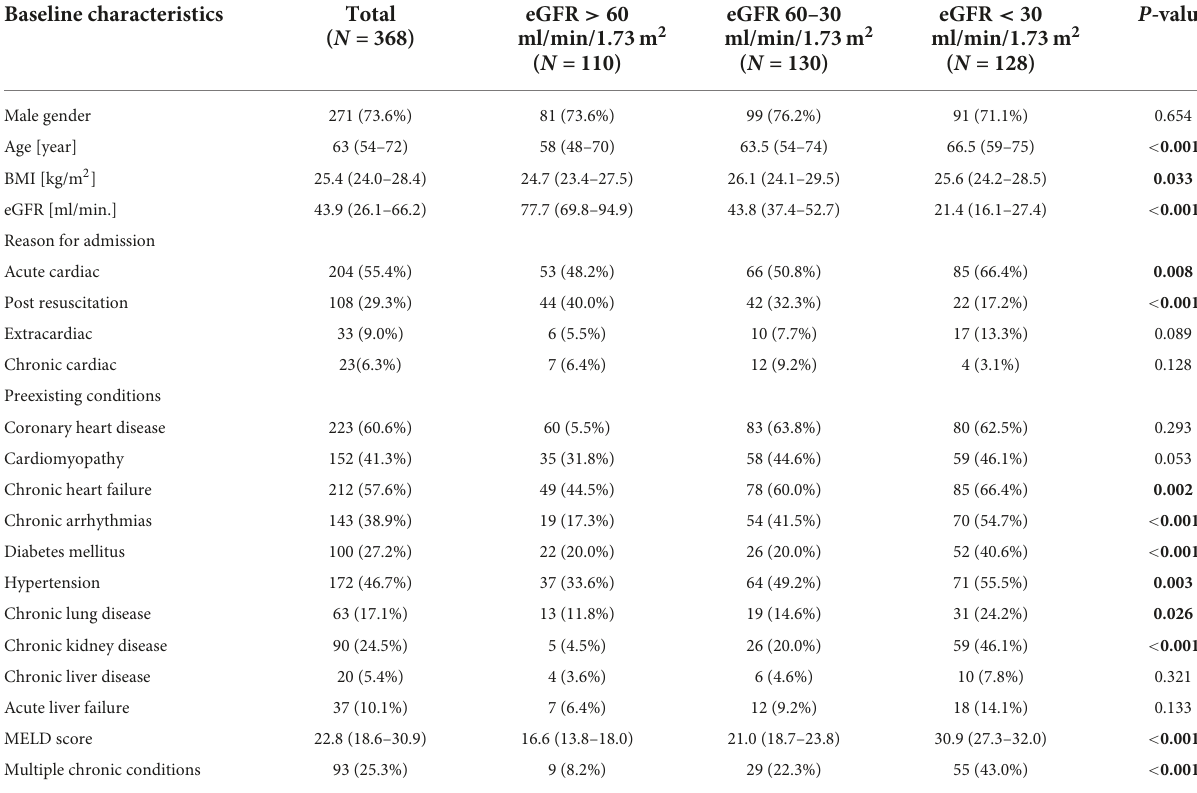
TABLE 1 Baseline characteristics of all patients before levosimendan